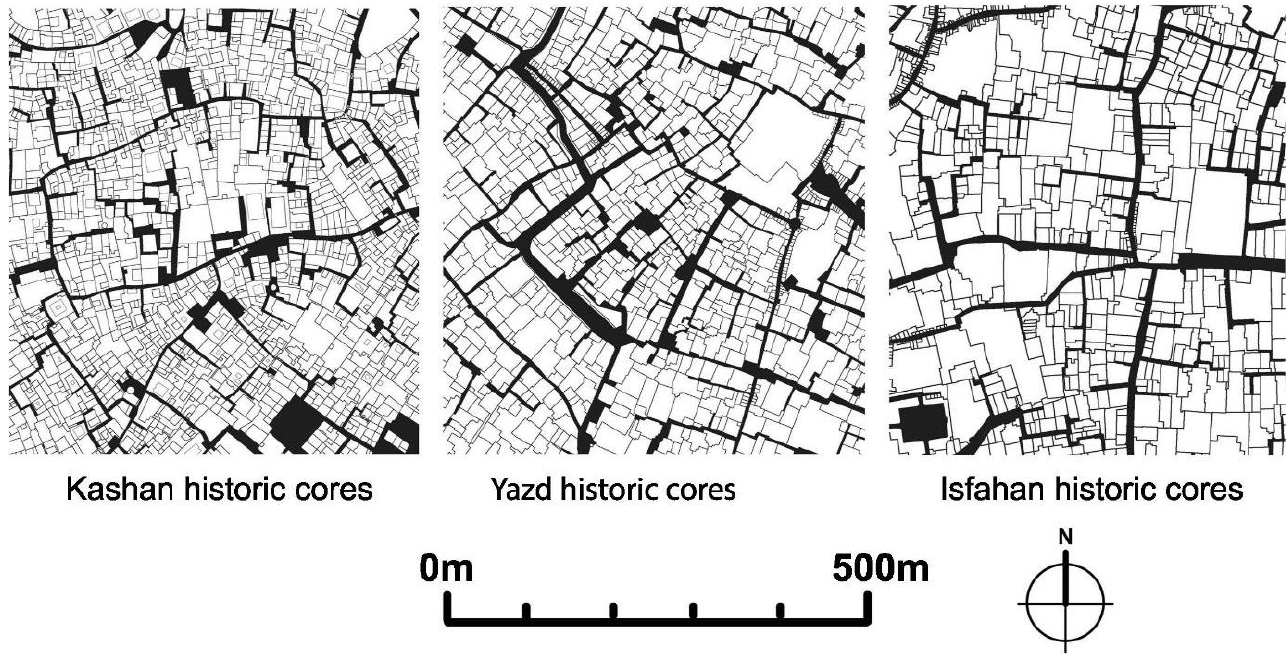
Figure 1. The cul-de-sac worked as a semi-private space in historic Iranian cities, while tiny squares provided access to dwellings and generated social groupings. Maps show the somehow untouched condition of these cities in 2018 [6] .